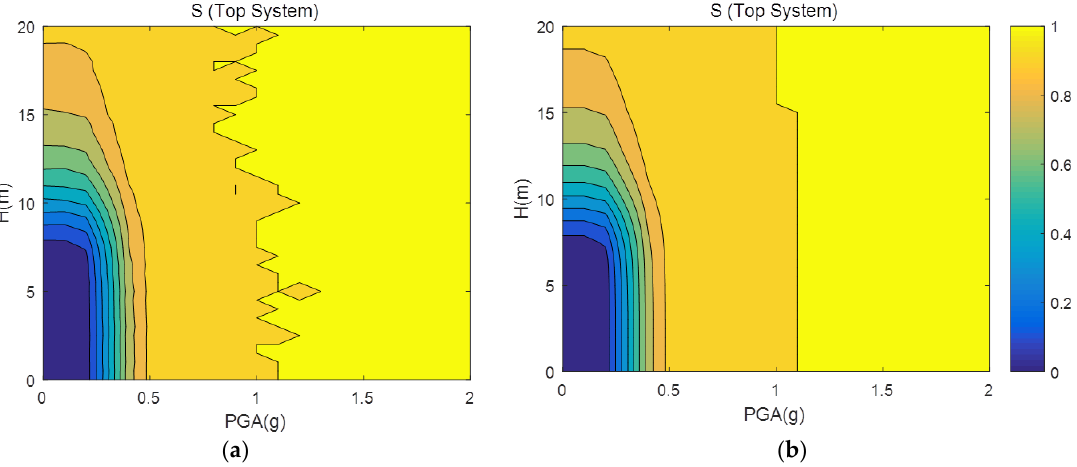
Figure 6. Comparison of multi-hazard system fragility results regarding the example C1 ∩ C2 ((3) partially dependent condition): ( a ) E-DQFM; ( b ) proposed (I-DQFM).